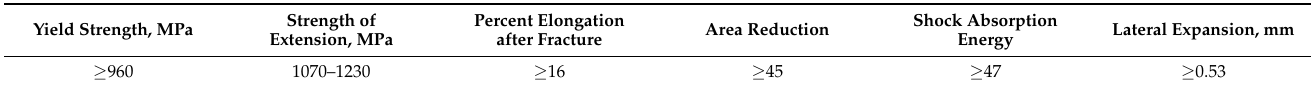
Table 3. Mechanical properties of 35CrNi3MoVR at room